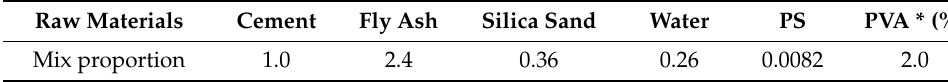
Table 1. Mixture weight proportion of the ECC specimens [37].